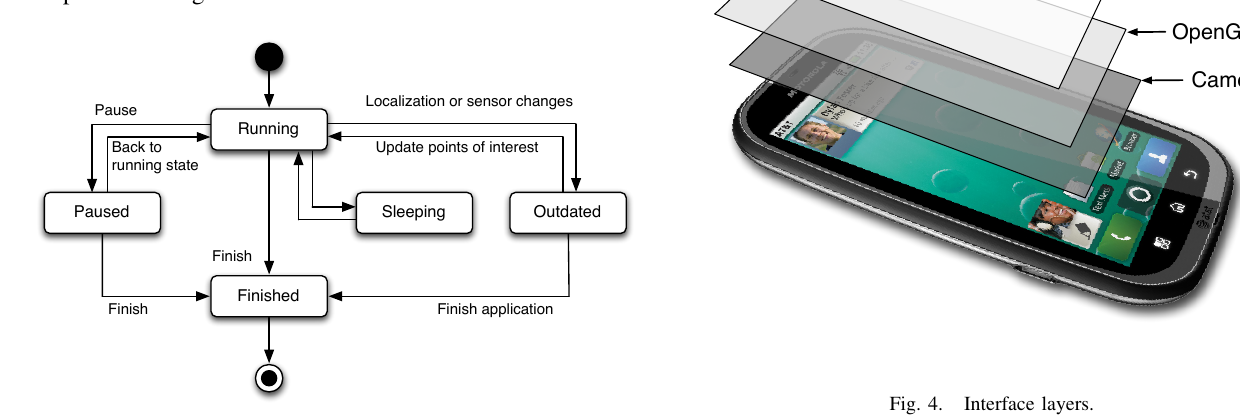
Fig. 4. Interface